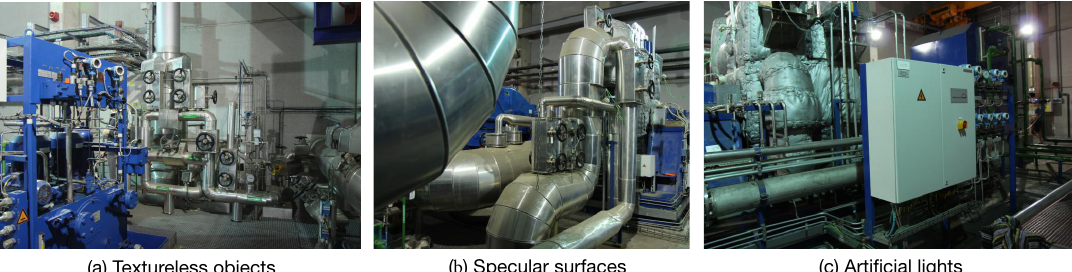
Figure 1. Challenges of collecting training data in industrial environments. ( a ) There are some uncovered regions within the training data using traditional video collection [6]. ( b ) There are some missing parts within the reconstructed 3D model on specular surfaces using Kinect Fusion [23,24].